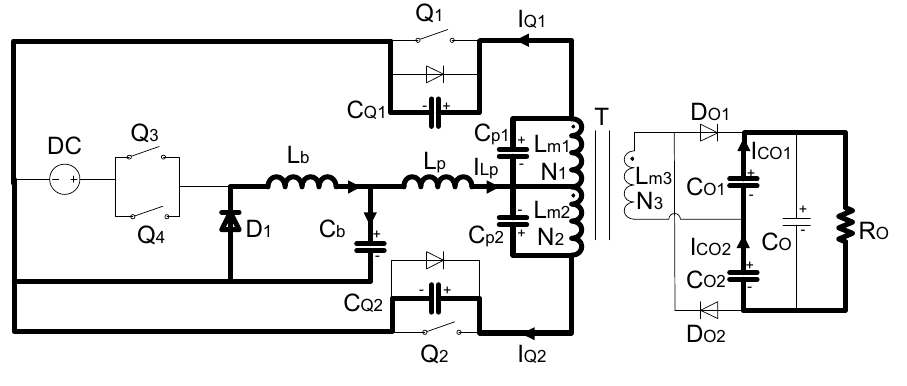
Figure 7. Equivalent circuit of mode II.